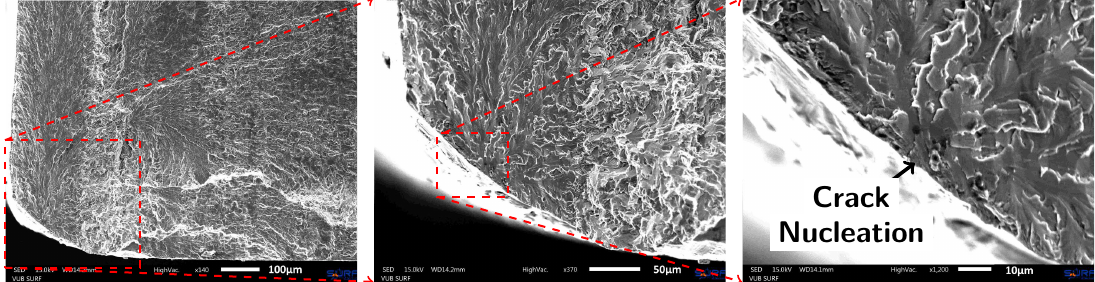
Figure 5. SEM images of the fracture surface of Specimen 1 (wrought material without capillaries). The fatigue crack initiated from the bottom left corner of the specimen.